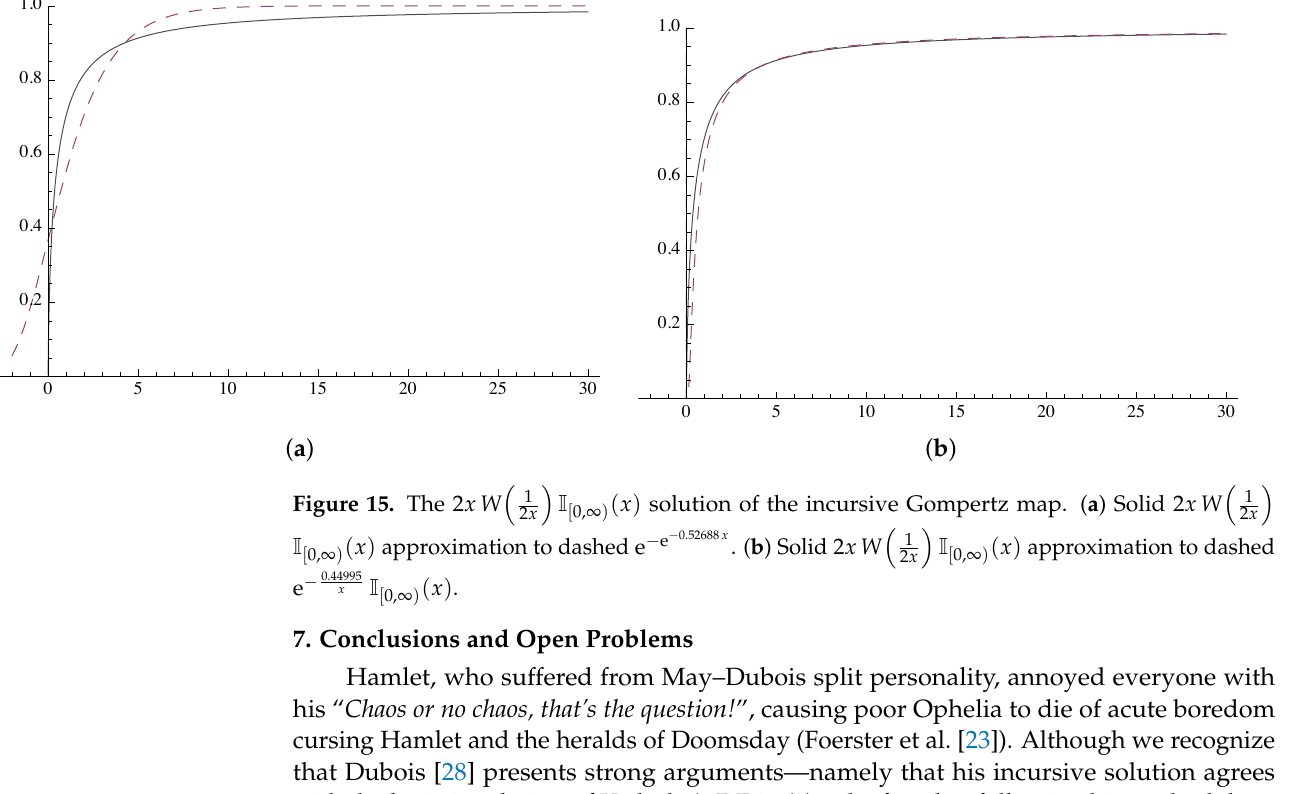
Figure 15. The 2 x W I ( x ) approximation to dashed e − e − 0.52688 x . ( b ) Solid 2 x W [ 0, ∞ ) e − 0.44995 x I [ 0, ∞ ) ( x )